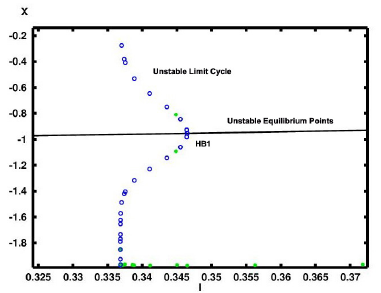
Figure 38. One-parameter bifurcation of membrane potential concerning externally ap- plied current with parameters a = 0.8 , b = 0.7 & c = 3 . Stable (green filled circles) and unsta- ble (blue vacant circles) branches of periodic solution of the BVP model showing di ff erent dynamical behavior